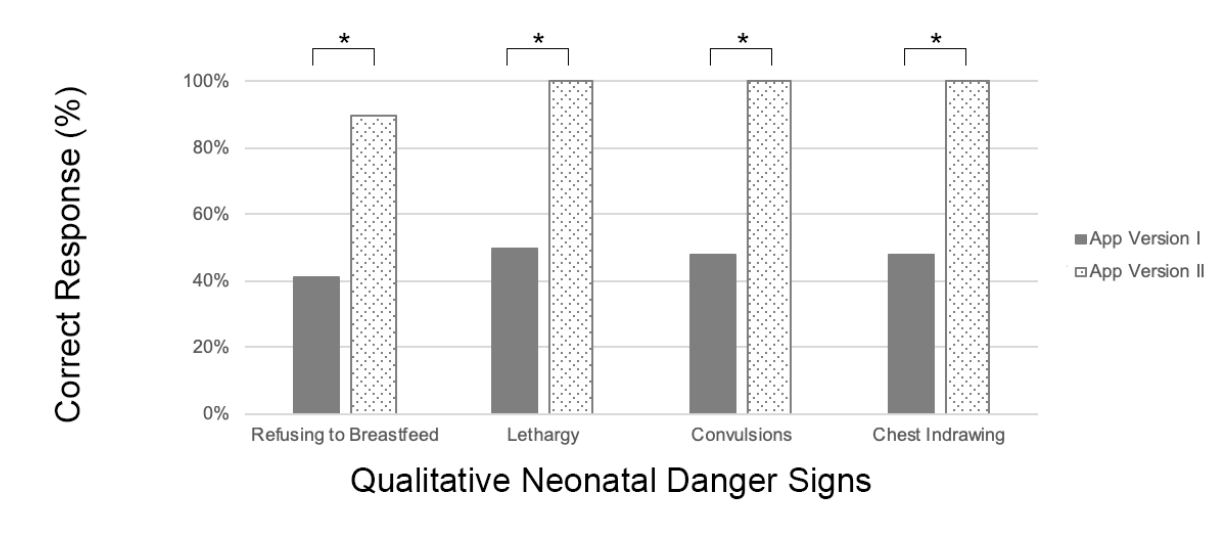
Figure 4. Comparison of mothers' ability to correctly respond to verbal scenarios using app versions I and II. Their ability to answer qualitative questions significantly improved across all four danger signs. * indicates P